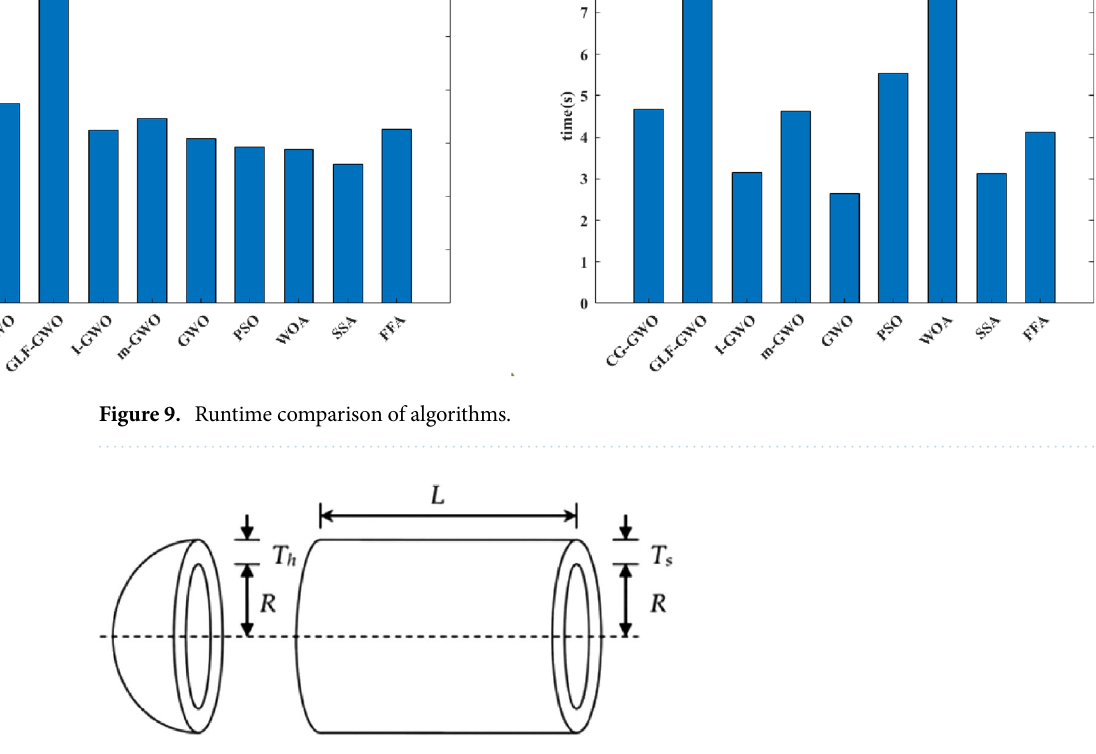
Figure 10. Pressure vessel design